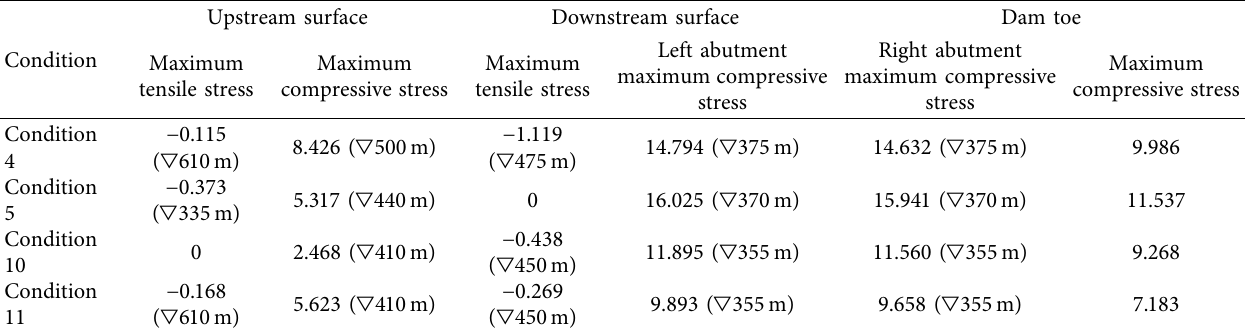
Table 6: Characteristic stress value and position of the arch dam under basic load combination (unit: MPa).